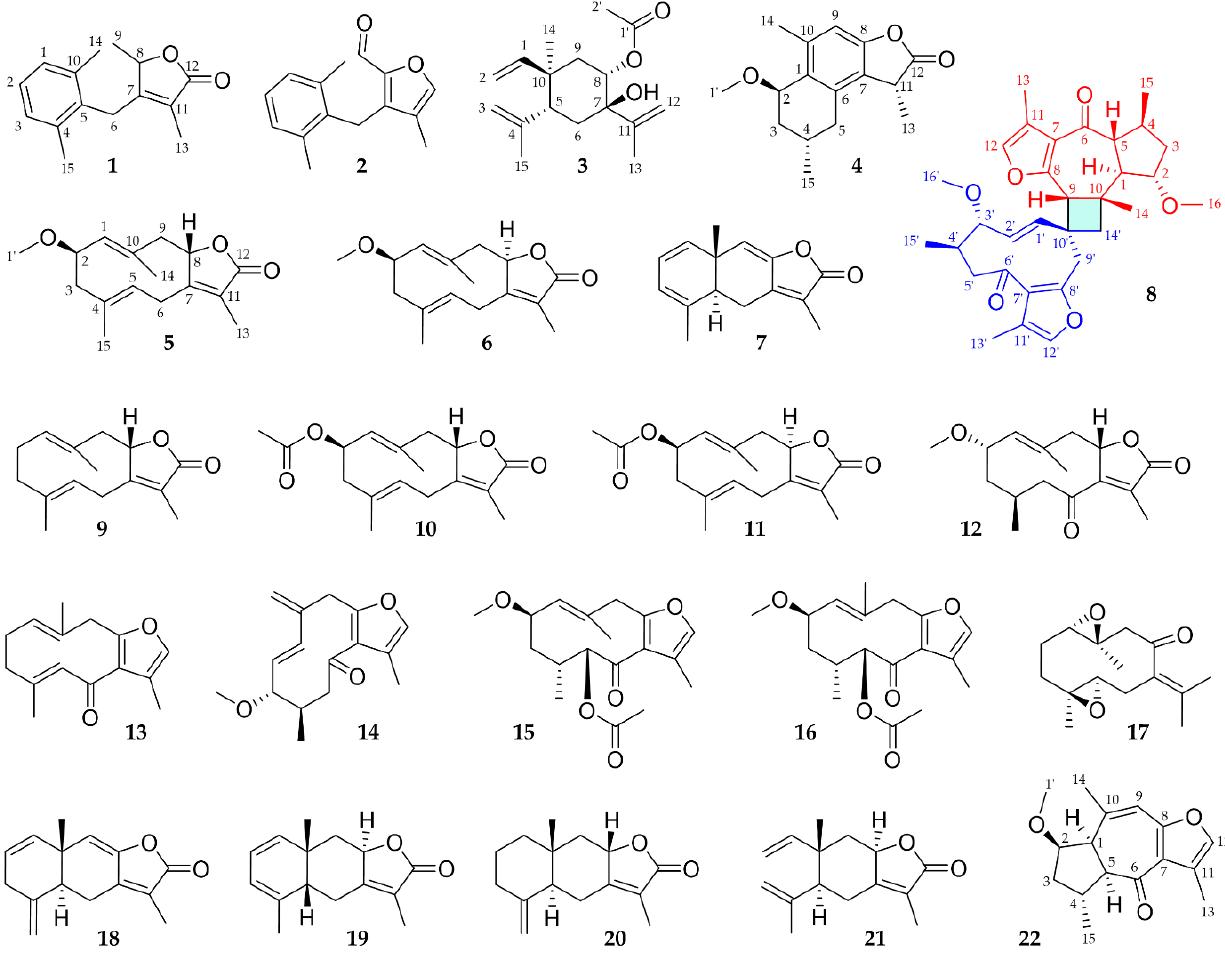
Figure 1. Chemical structures of isolated sesquiterpenes ( 1 – 7 and 9 – 22 ) and the sesquiterpene dimer ( 8 ) in their relative configuration. For compound 14 , absolute stereochemistry is depicted.